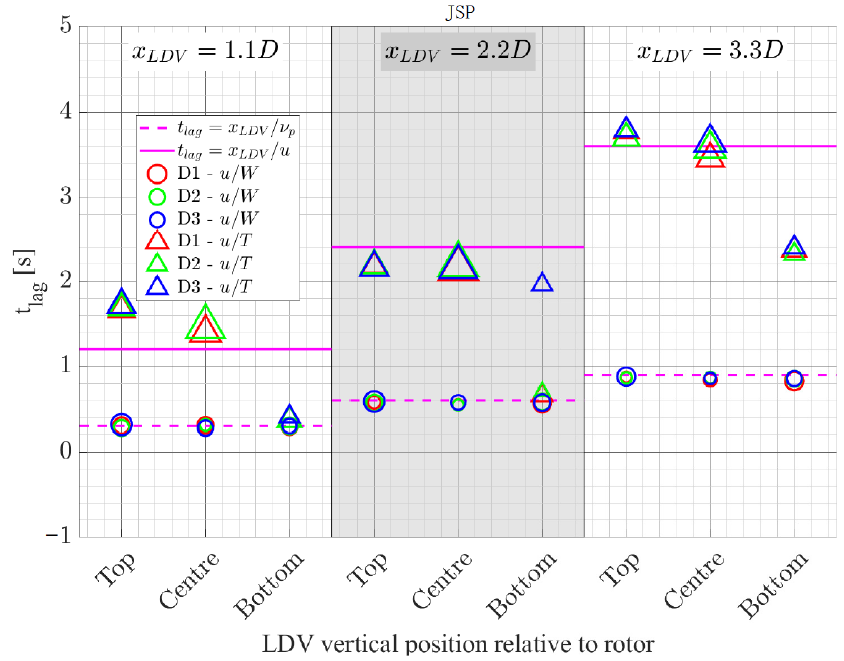
Figure 13. Comparison of lag between LDV, wave probe and thrust transducer signals obtained from cross-correlation for irregular wave cases. Three vertical sections for each LDV streamwise position. Filled markers are for cross-correlation between U / H and empty markers for U / T . Different marker colours indicate different rotor depths. Each section is divided in three for each LDV vertical position relative to the rotor: top, middle and bottom. The size of a marker is relative to the R value of the cross-correlation function ranging from 0.2 to